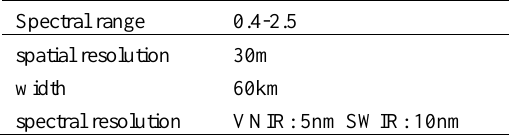
Table 2 . Parameters of visible short wave infrared hyperspectral